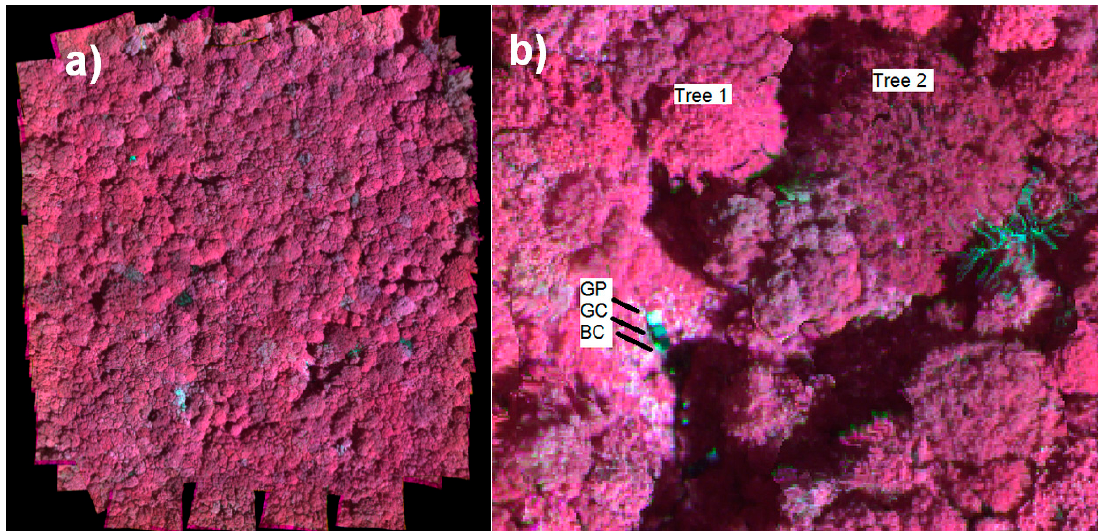
Figure 18. ( a ) False-colour reflectance mosaic of vertical flight f1 with FPI green, red and NIR range bands; ( b ) Part of the point cloud coloured with the spectral data, including locations of reference panels and measured trees.